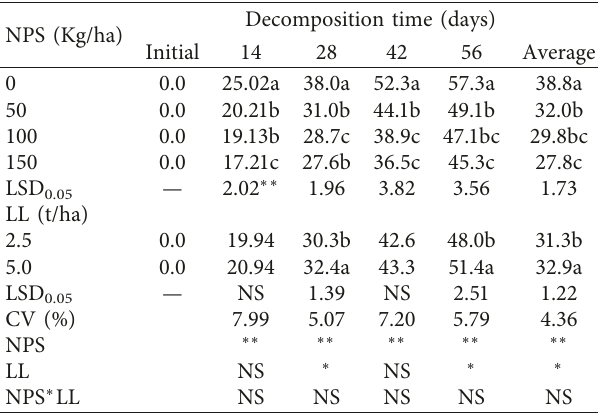
Figure 2: Dry mass remaining (% dry weight bases) (average of 56 days of decomposition) as affected by NPS and LL rates. Table 4: Half-life ( t 50 ) (days) over 56 days of